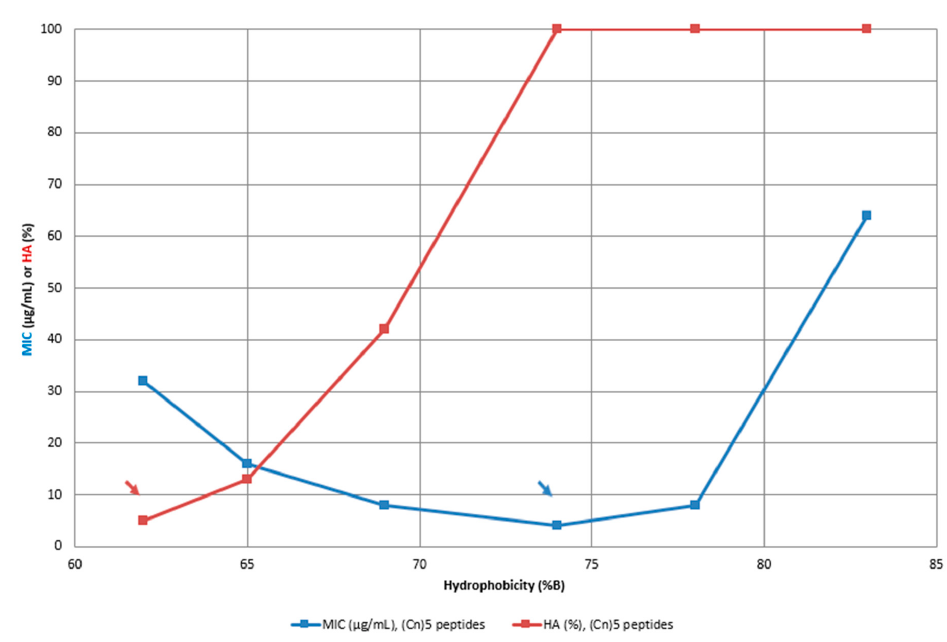
Figure 2. Relationship between hydrophobicity and antimicrobial activity (MIC, μ g/mL) and hemolytic activity (% hemolysis at 150 μ M) of the (C n ) 5 series of peptides. Data shown are obtained against P. aeruginosa and human erythrocytes. Arrows indicate the hydropmichobicity optima for MIC (minimum inhibitory concentration) and HA, the two optima being